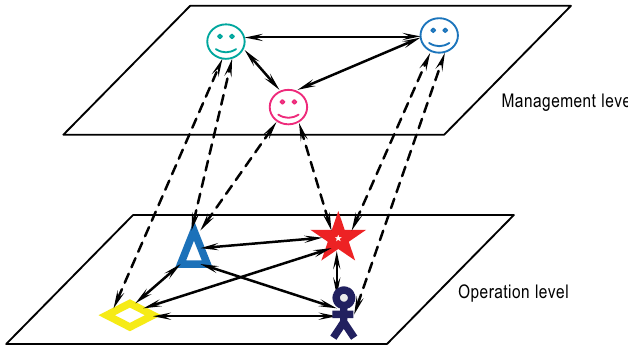
Fig 2. Abstracted dual-network